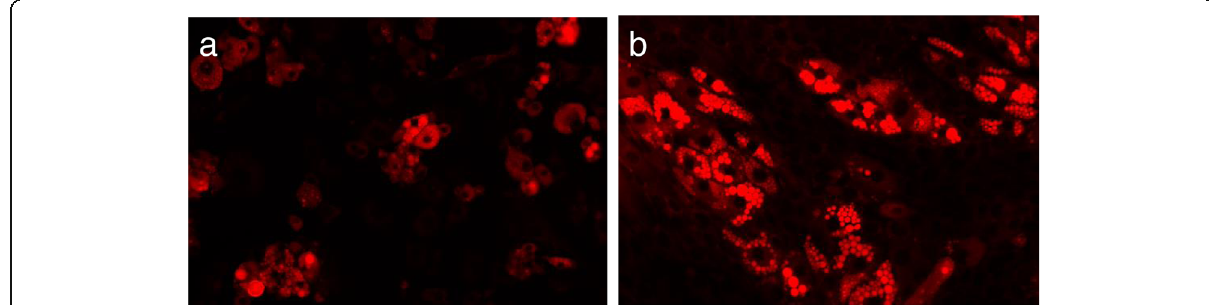
Fig. 2 Comparison of lipid droplets formation between ( a ) Myf5 negative and ( b ) positive progenitor cells, i.e. the 3 T3-L1 adipocytes and C2C12 myocytes respectively. Lipid droplets formation upon adipogenesis was stained by Nile Red solution and imaged at 20X